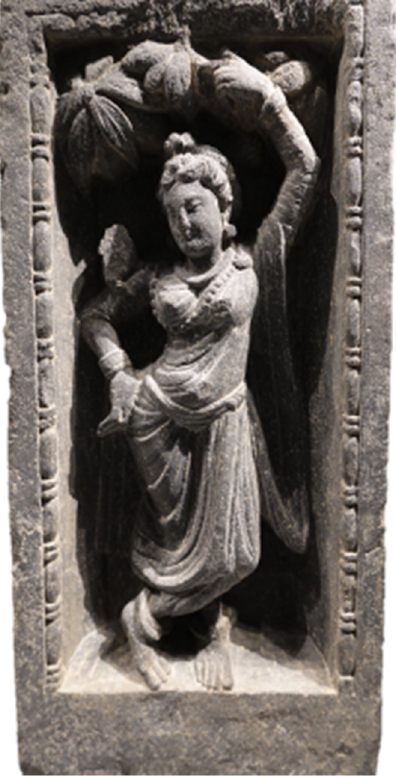
Figure 2. Schist relief with a śā labhañjik ā , c. 2nd–3rd century CE, Northwest Pakistan 7 .